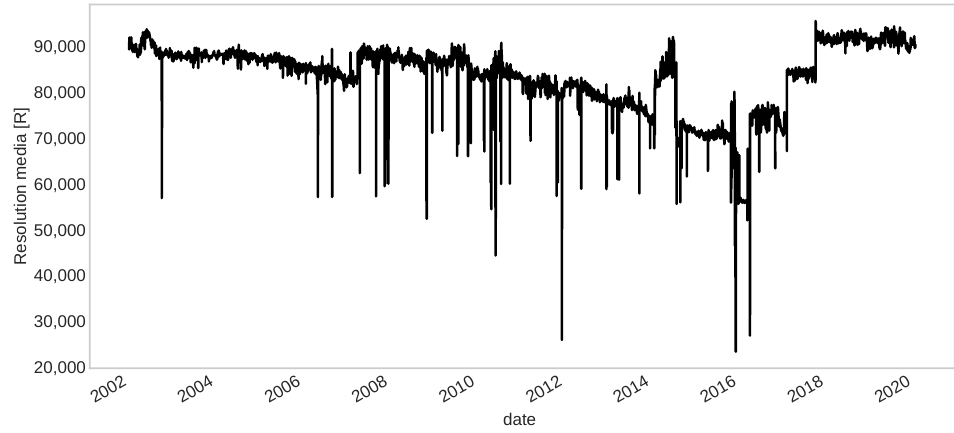
Figure 12. Resolution media signal obtained from a CCD.